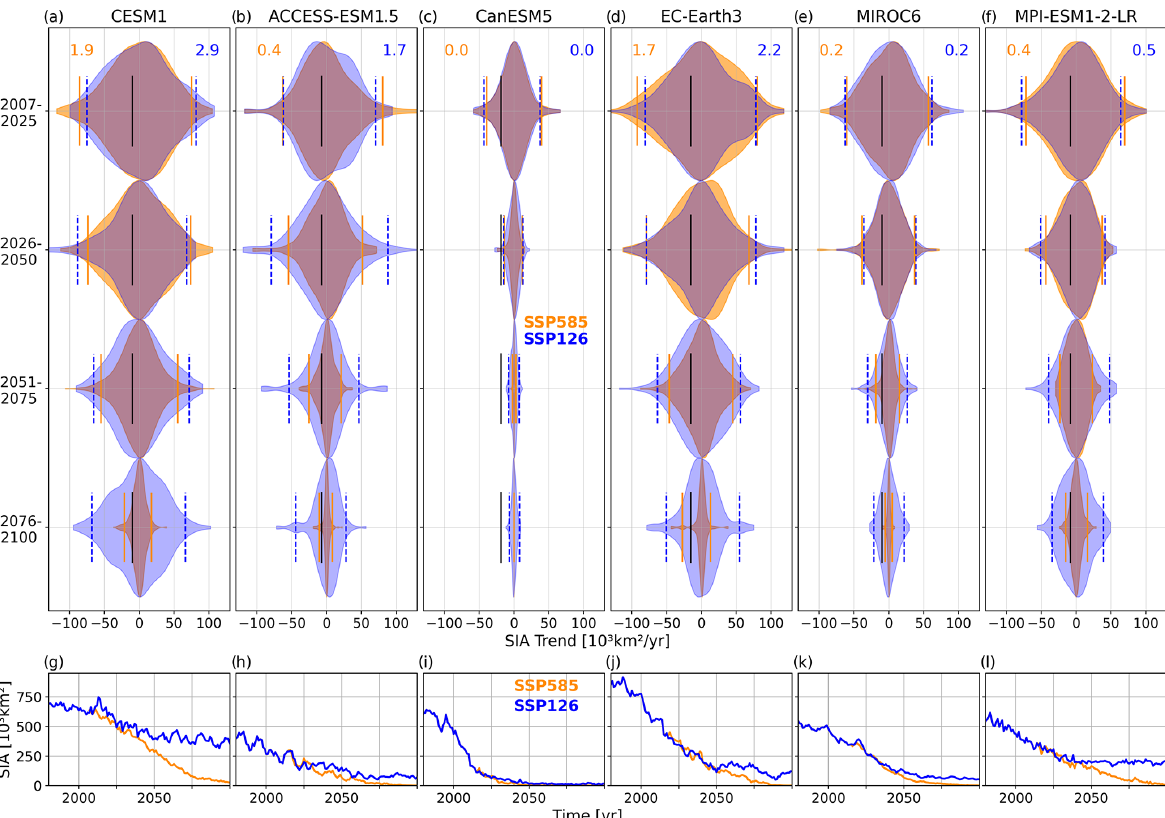
Figure 6. Violin plots showing the distribution of 5-year trends of SIA during different episodes of the 21st century in different model simulations. The orange and blue vertical lines indicate the 95th percentile for SSP585 and SSP126, respectively. The black vertical lines indicate the externally forced ice decline (strongest 30-year trend of the ensemble mean) of the respective SSP585 experiment. The number of RICEs per ensemble member for the SSP585 (left) and SSP126 (right) experiment is indicated in the top panels. The bottom panels show the ensemble mean SIA in the different simulations. For CESM the colors indicate CESM-LE (RCP8.5; orange) and CESM-2C